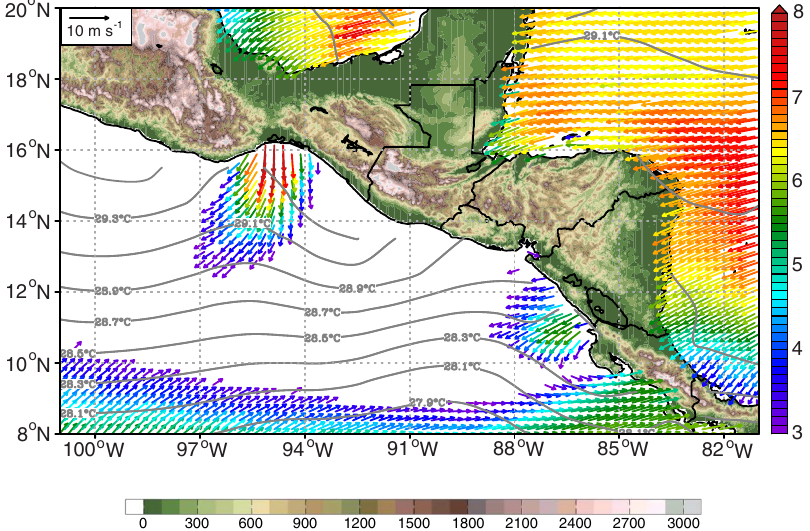
Figure 3. Climatological ocean surface wind and SST. Climatological hurricane season averaged ocean surface wind (vectors, unit: m s − 1 ) is derived from QuikSCAT V4 wind product. Colors of vectors indicate wind speeds as shown in the right colorbar, only plotting the region where the wind speed is higher than 3 m s − 1 . Climatological hurricane season averaged SST (contours, unit: °C) is plotted at intervals of 0.2 °C. Land topography (unit: m) is shaded green-brown. The map was generated using GrADS V2.1.0 (http://cola.gmu.